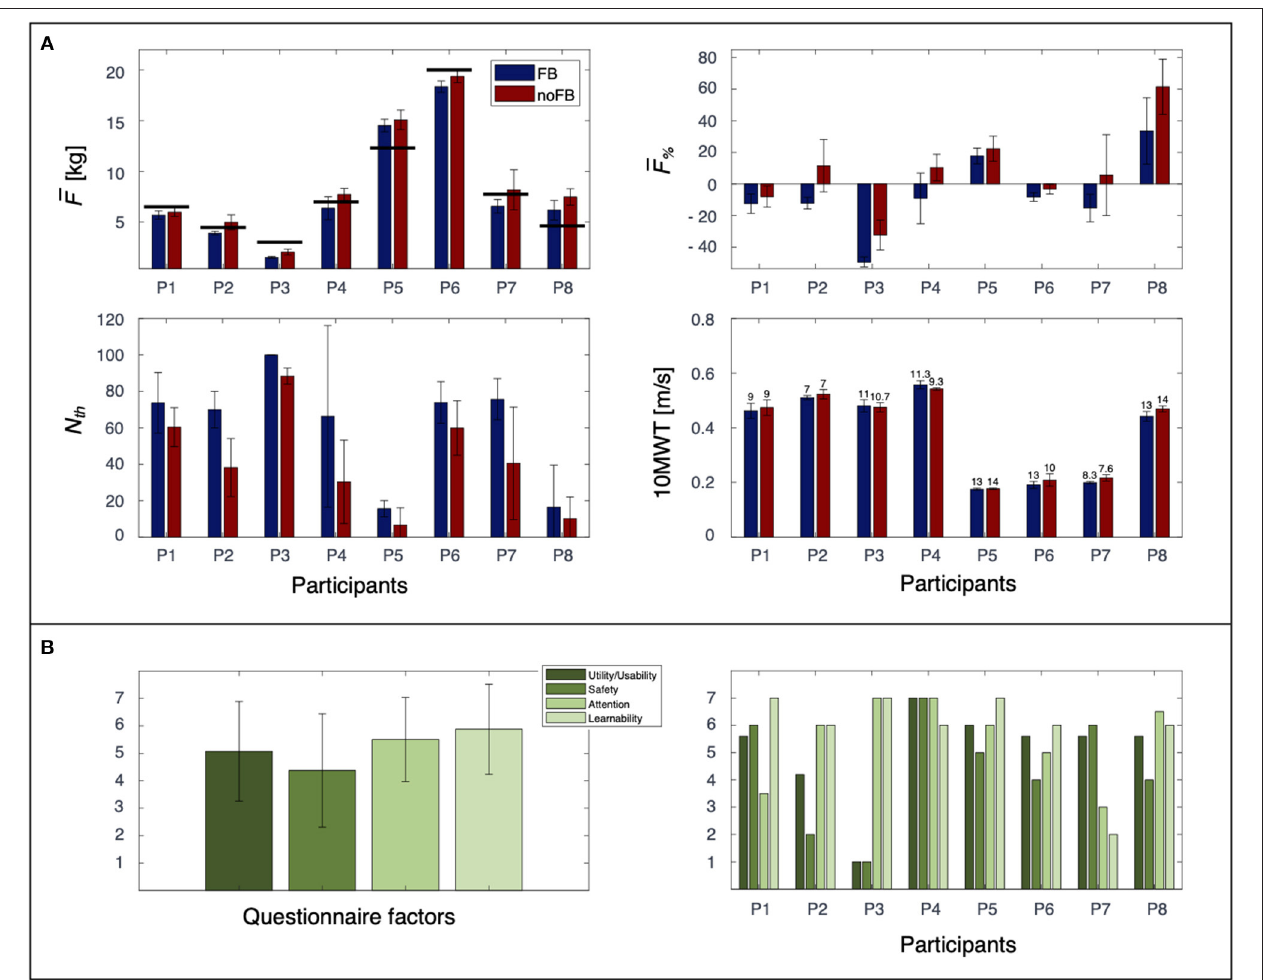
FIGURE 2 | Load and 10MWT data for P1–P8 are reported in (A) . Error bars indicate standard deviation. The target threshold Th for each participant is represented by black horizontal lines in the F graph and by the zero value in the F % graph. BORG values, averaged over three runs, are reported on top of the bars in the 10MWT graph. Overall experience with the auditory FB for each factor is reported in (B) as mean across participants (left) and separately for each participant (right).